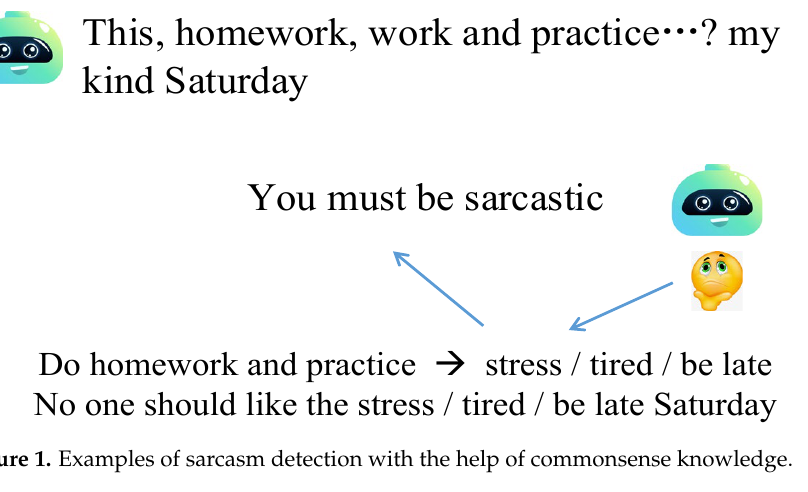
Figure 1. Examples of sarcasm detection with the help of commonsense knowledge.